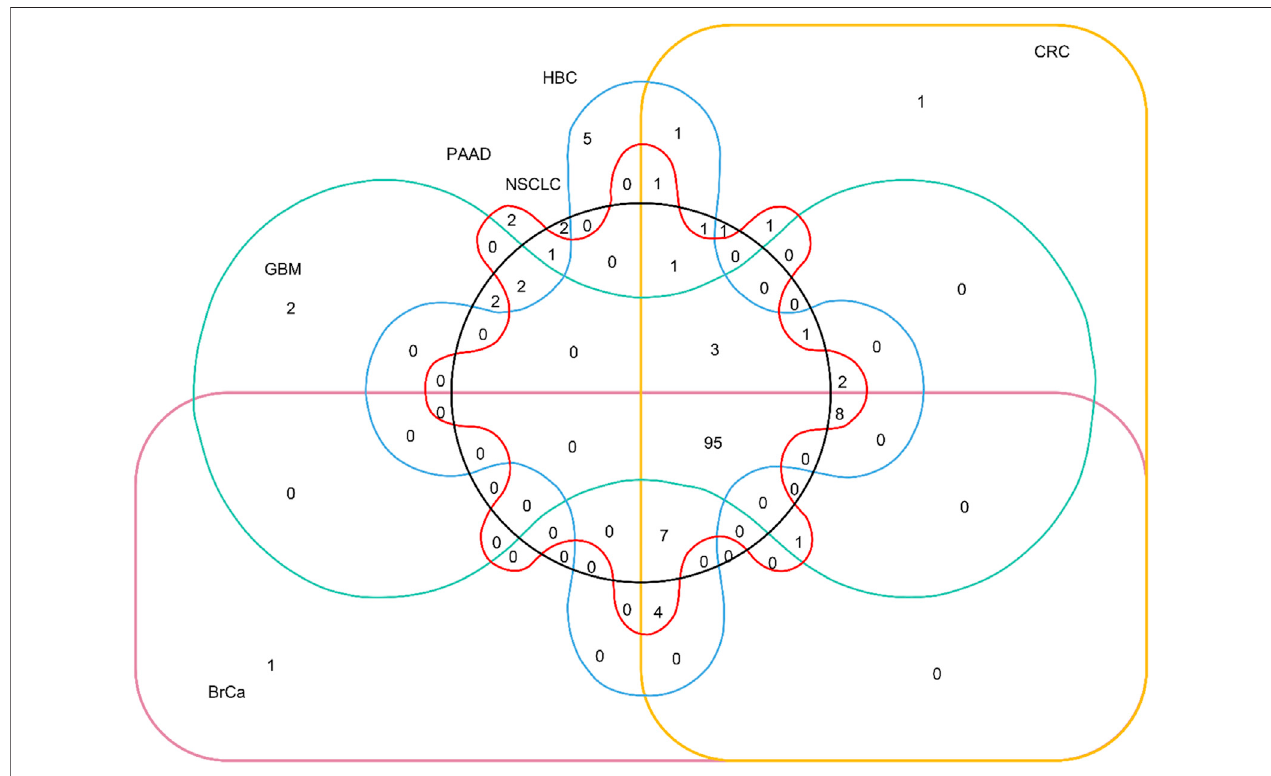
FIGURE 2 | Venn diagram of distribution relationship between the candidate genes and the six tumor groups. The 95 genes in the lower right corner are selected from 285 candidate genes.